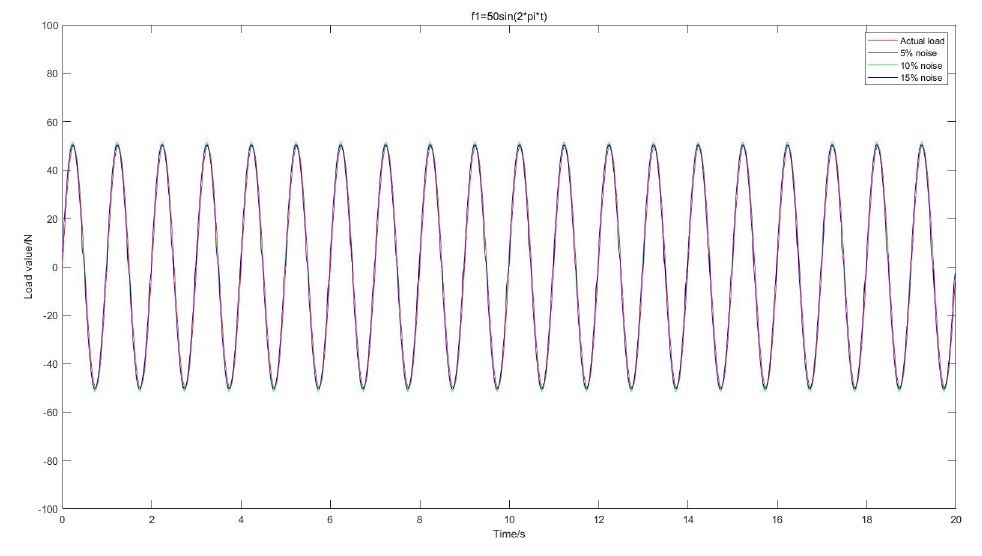
Figure 10. f 1 load identification with different noise levels.